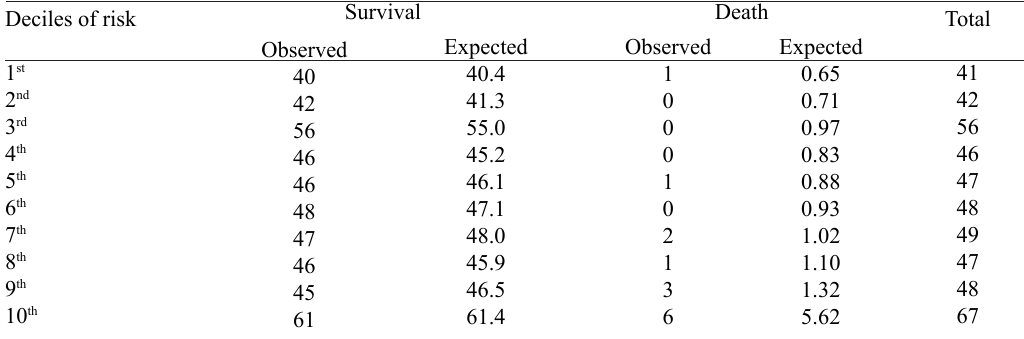
Table 2. Hosmer-Lemeshow contingence table for goodness of fit as determined for mortality in isolated CABG patients. Calculated Chi-square = 6.89 P =0.55.